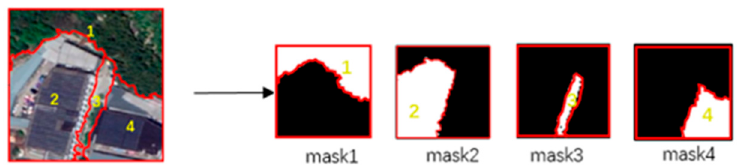
Figure 7. Demonstration of masks. Mask 1–4 reflects the position of superpixel block 1–4 in image respectively.